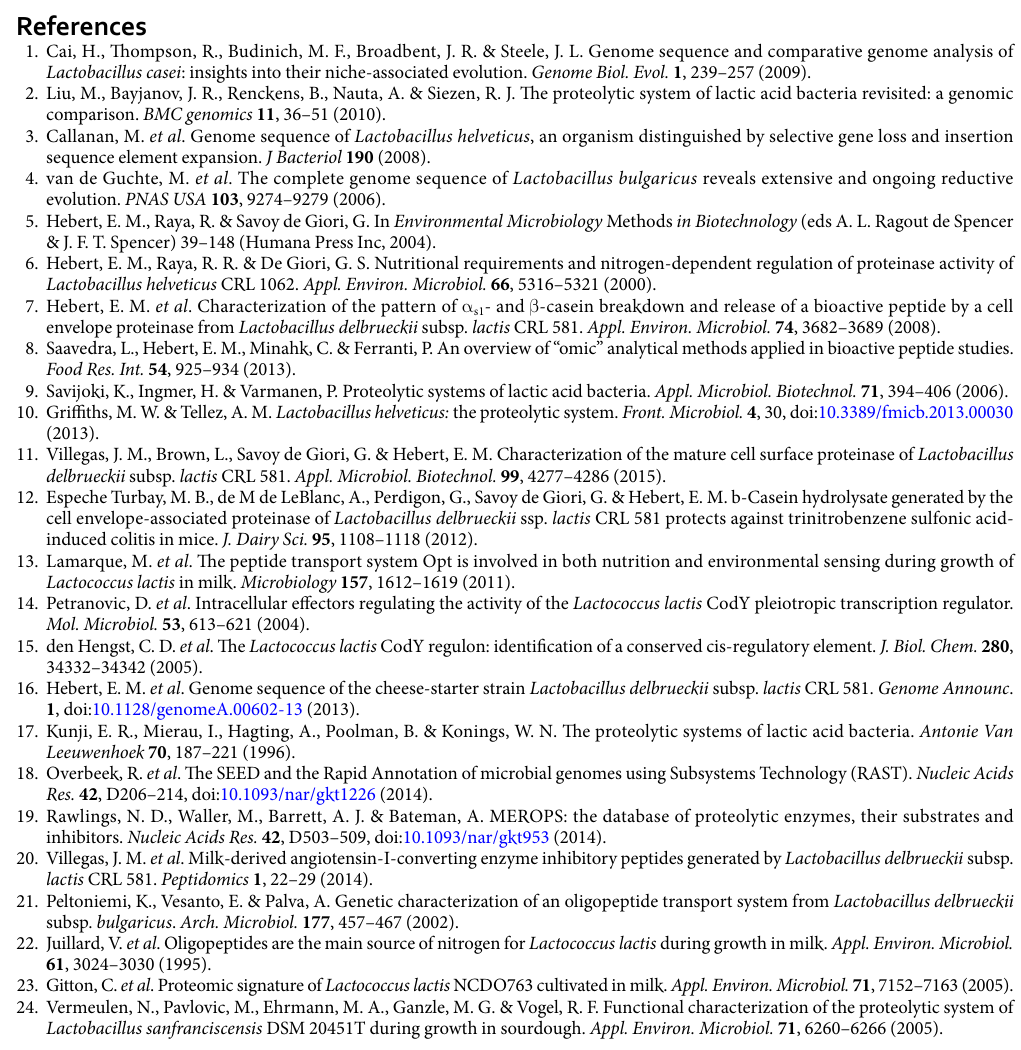
ting onto a MALDI target for co-cristallization. Protein digestion and MS were performed by the proteomic core facility CEQUIBIEM (Buenos Aires, Argentina). All MS data were collected by using an Ultraflex II BukerDaltonic MALDI TOF/TOF equipment. Data were acquired in reflector mode from a mass range of 700 to 4,000 Da, and 1,250 laser shots were averaged for each mass spectrum. Each sample was internally calibrated with trypsin autolysis and keratin peaks. The generated peak list was based on signal-to-noise filtering and an exclusion list. The resulting file was then searched by Mascot with database search parameters including a mass tolerance of 20–100 ppm, one missed cleavage, oxidation of methionine, and carbamidomethylation of cysteine. Only matched proteins with sig- nificant scores ( P < 0.05) were considered. The obtained hit was validated by MS/MS fragmentation of one or two high S/N peaks per sample. All searches were performed against the database of L . delbrueckii subsp. lactis CRL 581 from the annotated genome (http://www.ncbi.nlm.nih.gov/genome/514?genome_assembly_id = 167382). Phylogenetic Analysis of the YebC